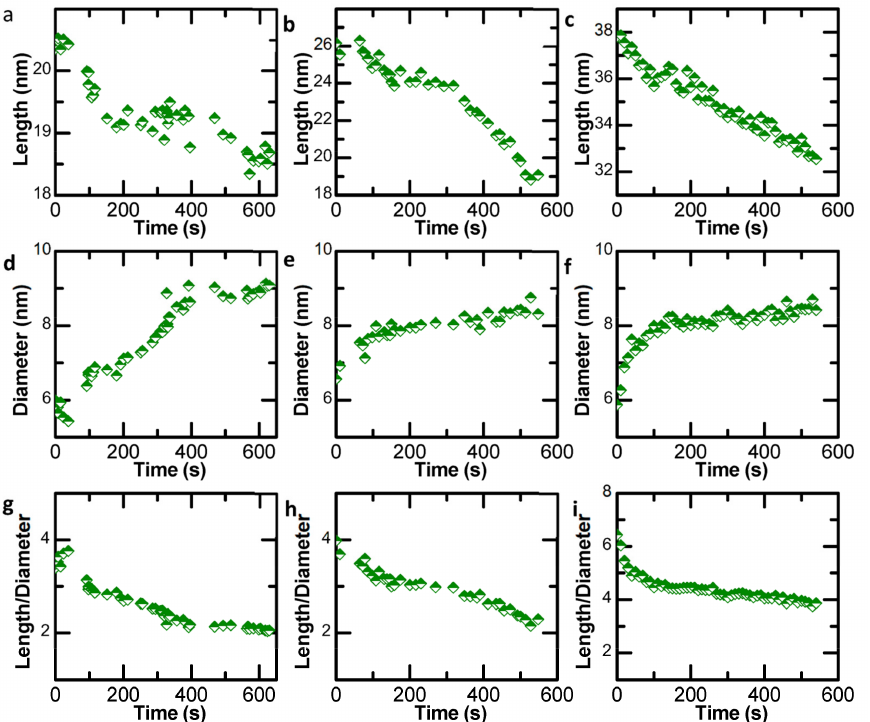
Figure 6. Statistical analyses showing the fluctuation of length ( a – c ), diameter ( d – f ) and aspect (length/diameter) ratio ( g – i ) of Au NRs along with time in Videos S1–S3. The Videos in supplemen- tary information (SI) were played at seven times that of normal